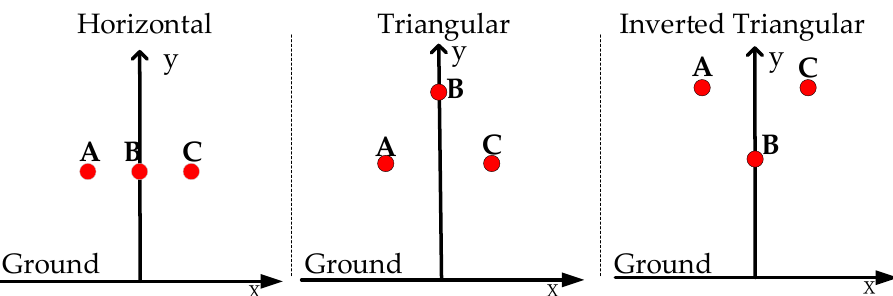
Figure 8. Different arrangements of three-phase transmission lines. A: A-phase transmission line; B: B-phase transmission line; C:C-phase transmission line